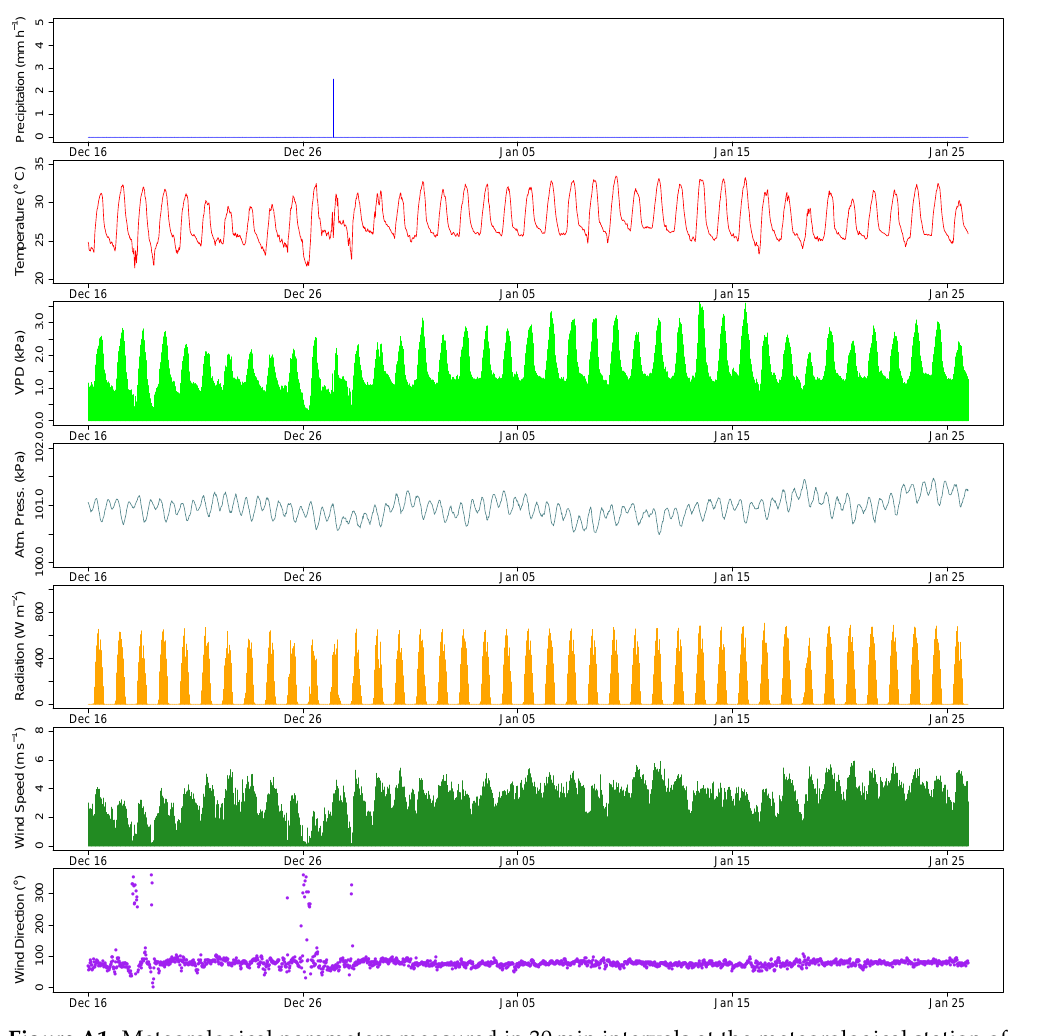
Figure A1. Meteorological parameters measured in 30min intervals at the meteorological station of Palo Verde Research Station, Costa